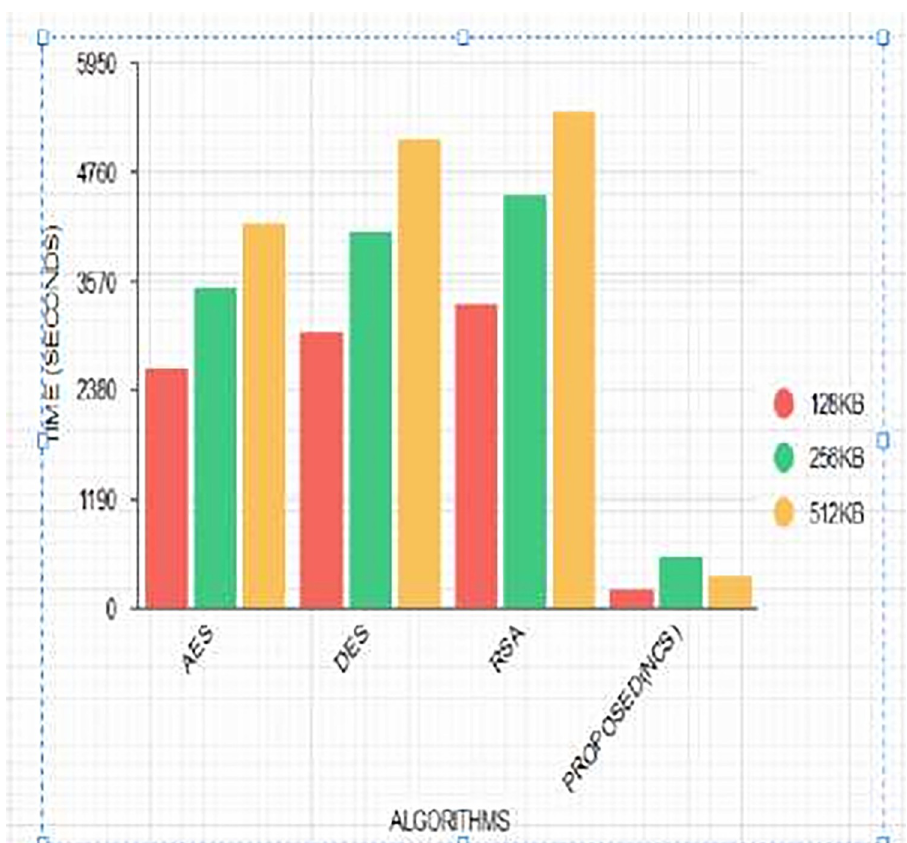
Fig 16. Comparing encryption time of proposed (NCS) algorithm with conventional algorithms using different key